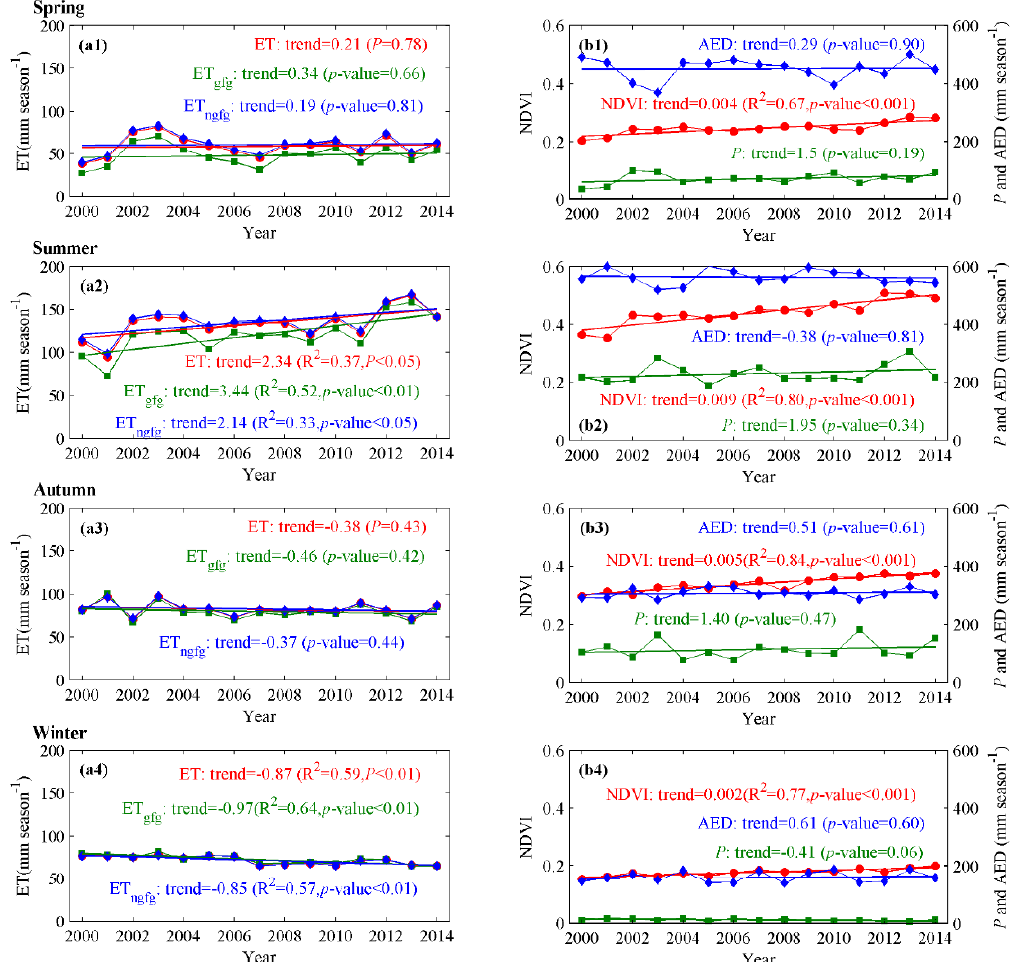
Figure 6. Interannual variability of ( a1 ) spring-ET, ( a2 ) summer-ET, ( a3 ) autumn-ET, and ( a4 ) winter-ET across the entire CLP, along with main areas implemented with the GFG project (ET gfg ) versus other CLP areas not implemented with the GFG project (ET ngfg ) during 2000–2014 at the spatial-average level. The interannual variabilities of NDVI, P , and AED in ( b1 ) spring, ( b2 ) summer, ( b3 ) autumn, and ( b4 ) winter across the entire CLP are also shown for reference. The broken lines with colors of red, green, and blue in the left panels show the interannual variability of ET across the entire CLP (denoted as ET), ET gfg , and ET ngfg for di ff erent seasons, respectively, with annual trends (mm yr − 1 ) indicated by the texts in the same color. The broken lines and texts with colors of red, green, and blue in the right panels show the interannual variability and annual trends of NDVI, P , and AED, respectively.